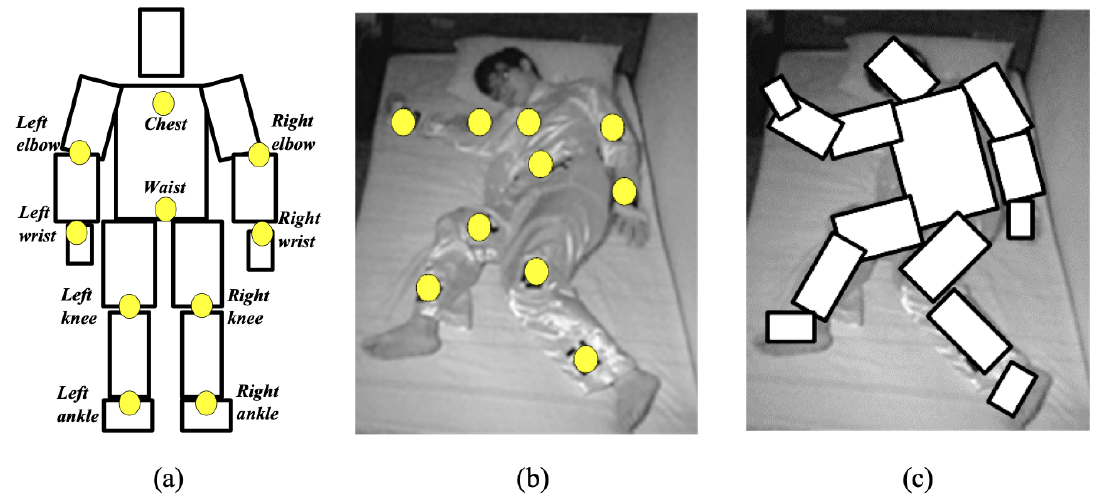
Figure 4. An example of reconstructed human model by fully detected joints. ( a ) A standard model with a standing pose. ( b ) A sleep image overlaid with the detected/tracked joints found by keypoint match and structured learning. ( c ) Reconstructed model of the lateral